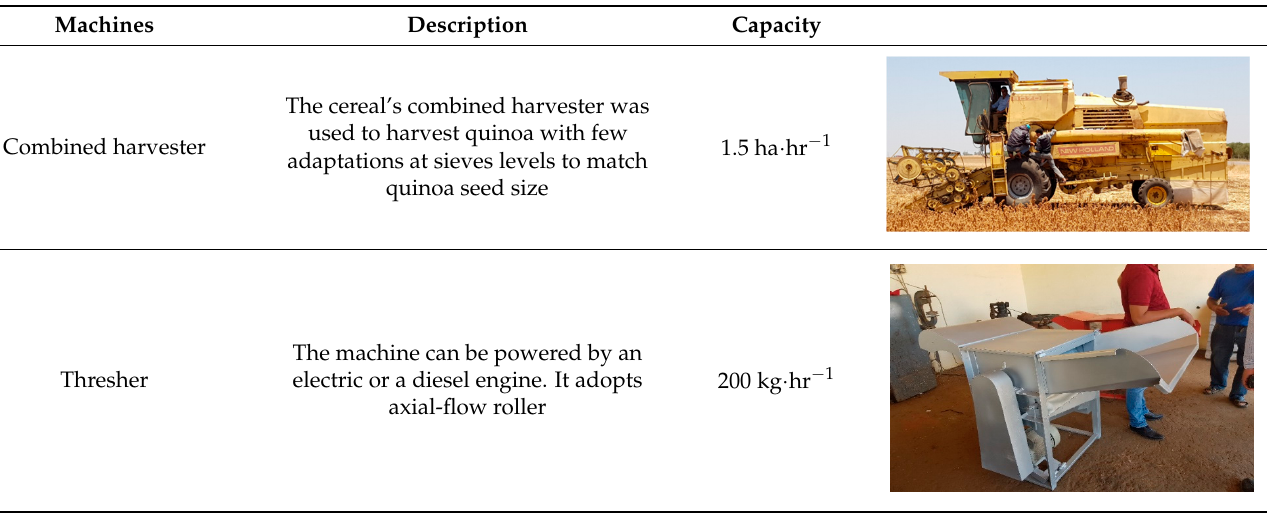
Table 2. Harvest and post-harvest machines locally developed.